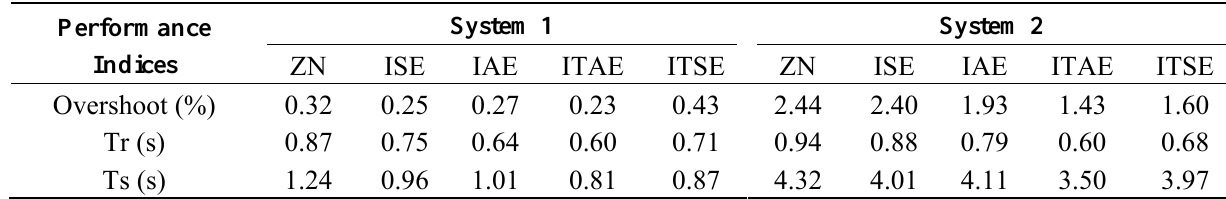
Table 2. Performance indices of PID